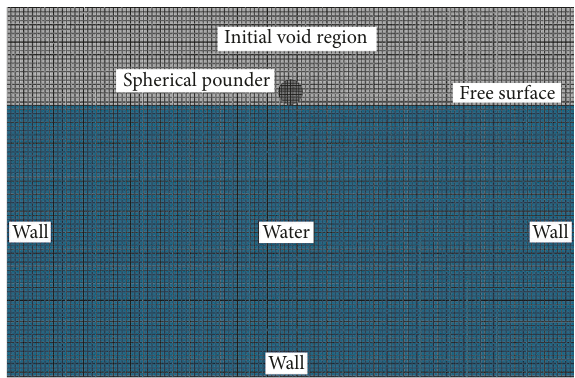
Figure 6: The computational domain, boundary conditions, and grid distribution for water entry problem of spherical